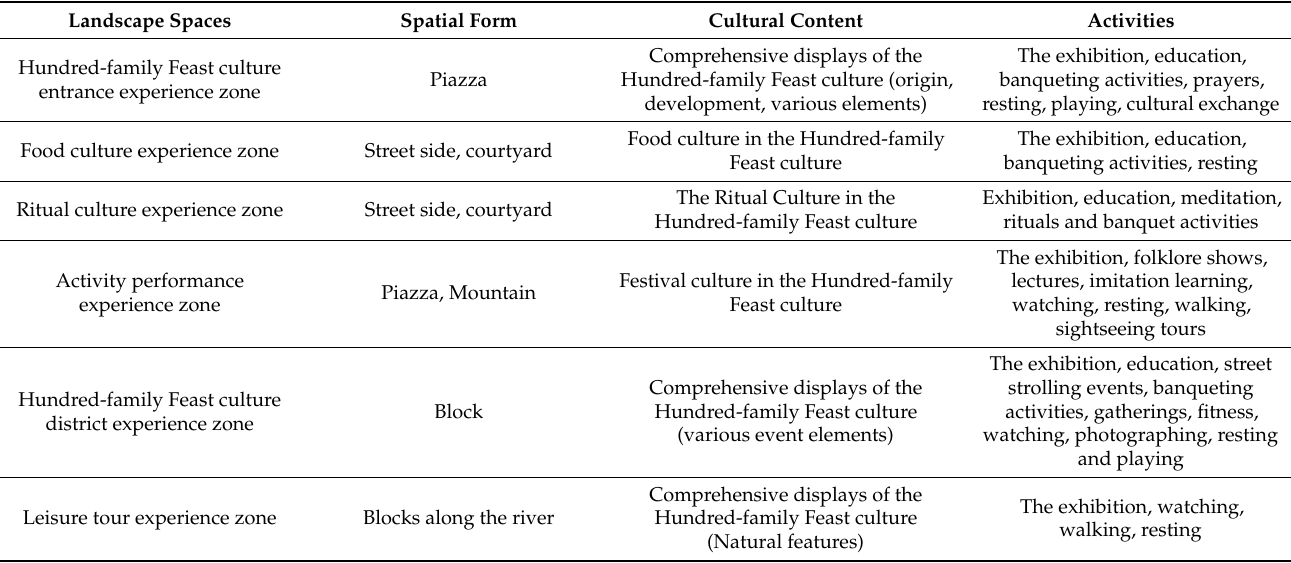
Figure 7. Landscape spatial structure analysis diagram of Taishun Hundred-family Feast. Table 2. Landscape space and cultural